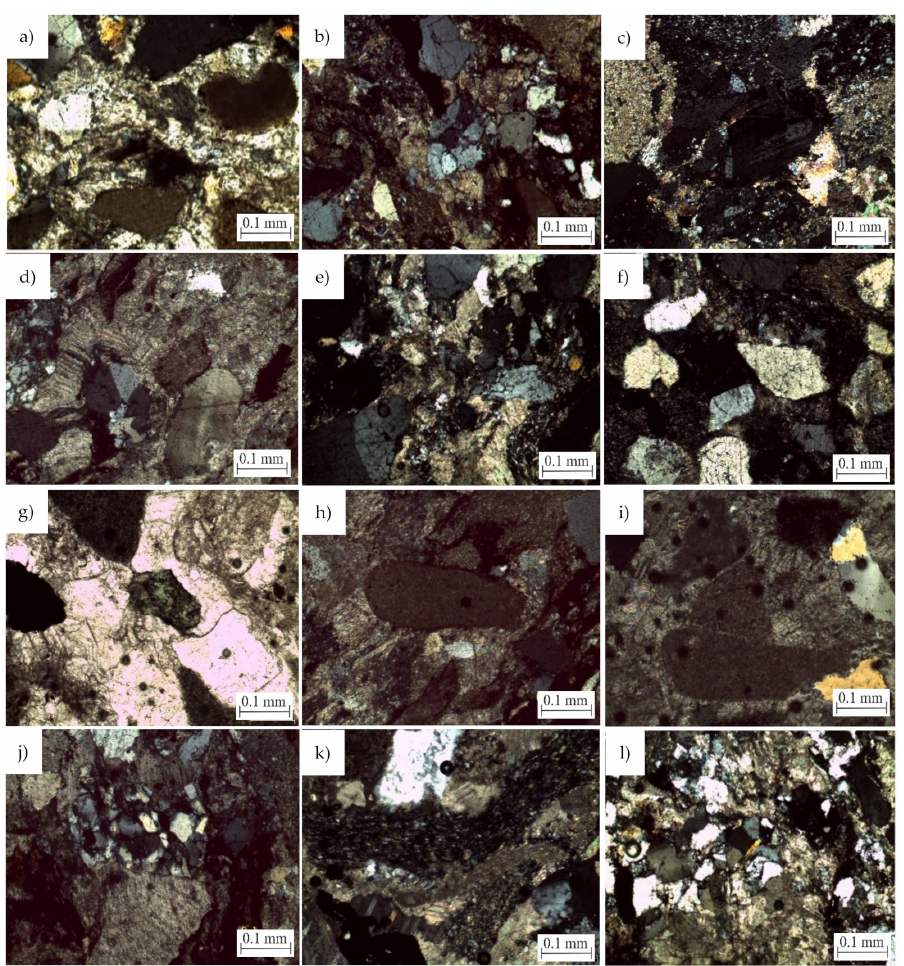
Figure 8. Photomicrograph illustrating ( a – c ) monocrystalline quartz, polycrystalline quartz and plagioclase, ( d ) orthoclase, ( e ) slate clast, ( f ) schist clast, ( g ) greenstone, ( h , i ) micritic limestone with pyrite and micritic limestone, ( j ) sandstone clast, ( k ) siltstone clast, and ( l ) tourmaline. Feldspar varies between 2 and 5%. Plagioclase and alkali feldspar are the components of litharenite. Plagioclase (Figure 8c) grains have been altered into sericite. Perthite and orthoclase make up alkali feldspar (Figure